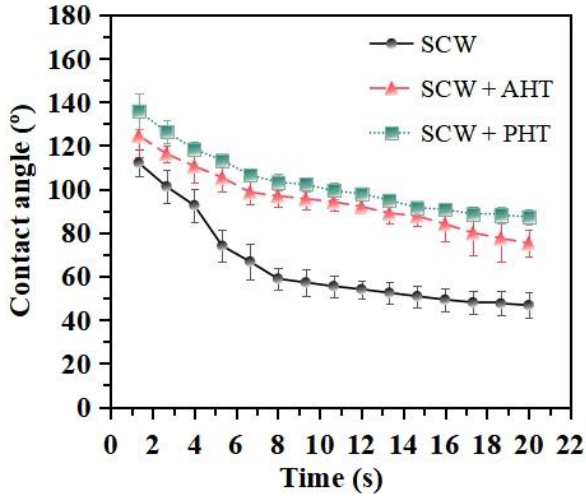
Figure 3. Contact angle of distilled water on wood surface. SCW, surface-compressed wood without post-treatment; SCW + AHT, surface-compressed wood with atmospheric steam heat treatment; SCW + PHT, surface-compressed wood with pressurized steam heat treatment. 3.3. Chemical Structure The chemical structure of the wood components is essential for a further understand- ing of the fixation mechanisms of SCW + PHT. Figure 4 presents the FTIR spectra of SCW, SCW + AHT, and SCW + PHT in the wavenumber range of 800 – 3800 cm −1 . Absorbance at